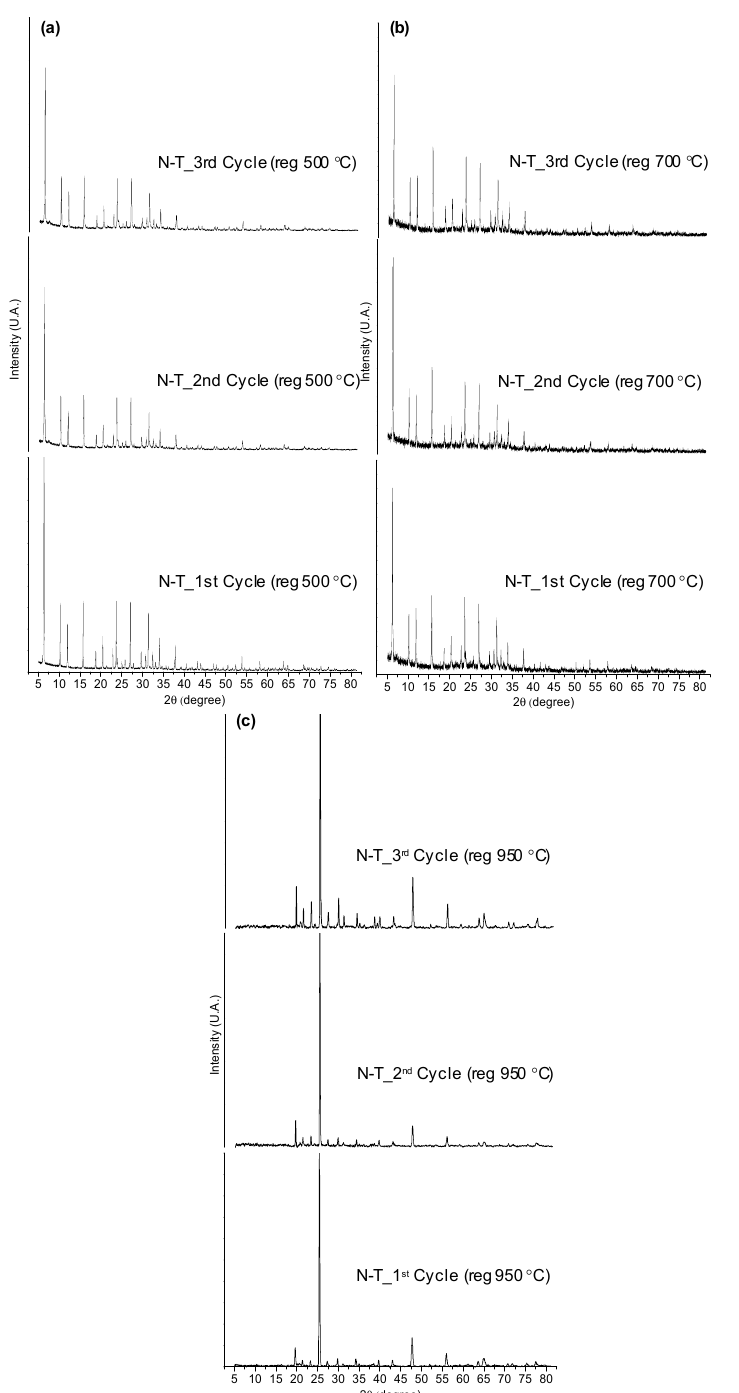
Figure 6. XRD of Li-LSX zeolite (non-treated microalgae) regenerated at ( a ) 500 °C, ( b ) 700 °C and ( c ) 950 °C.